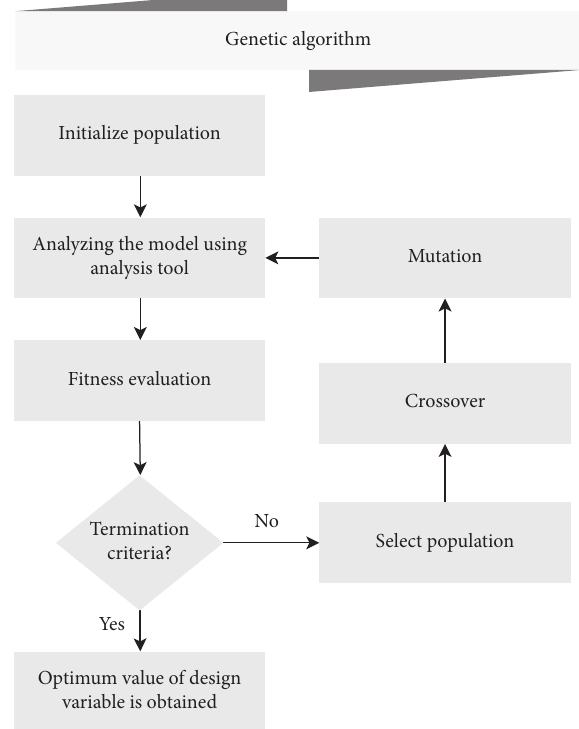
Figure 13: Genetic